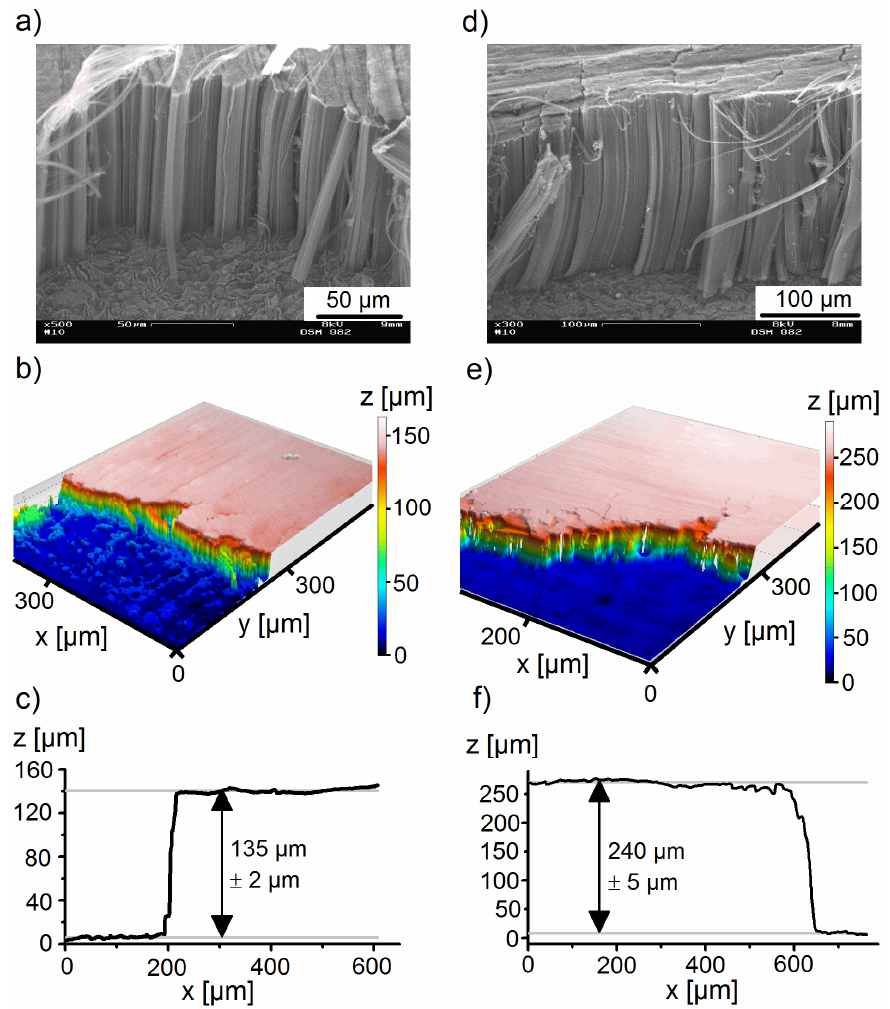
Figure 5. SEM image, confocal microscopy image and profile of VACNT grown with Al 2 O 3 buffer layer (54 nm), Fe x Co y O z catalyst layer [20 nm, process duration of 20 min ( a – c ), and 75 min ( d – f )].